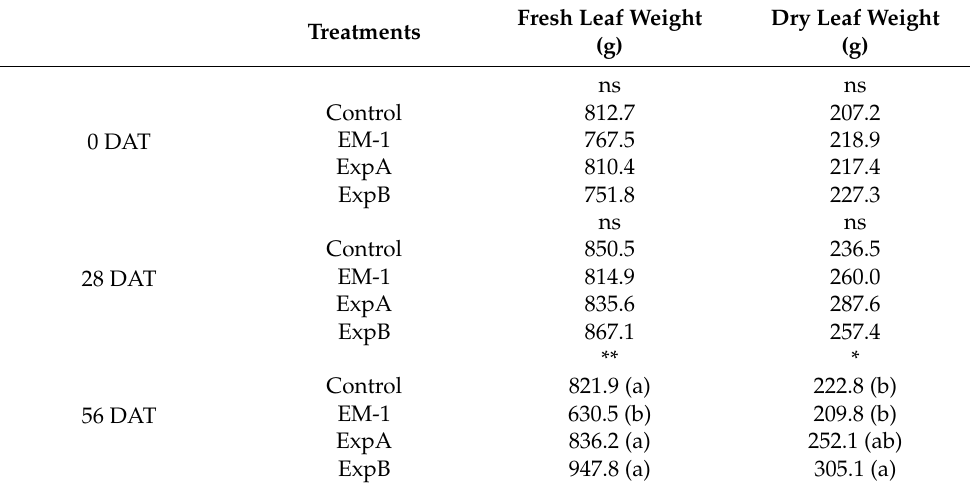
Table 1. Changes in fresh and dry leaf weight, respectively, at 0, 28 and 56 DAT with the untreated control, EM-1, ExpA and